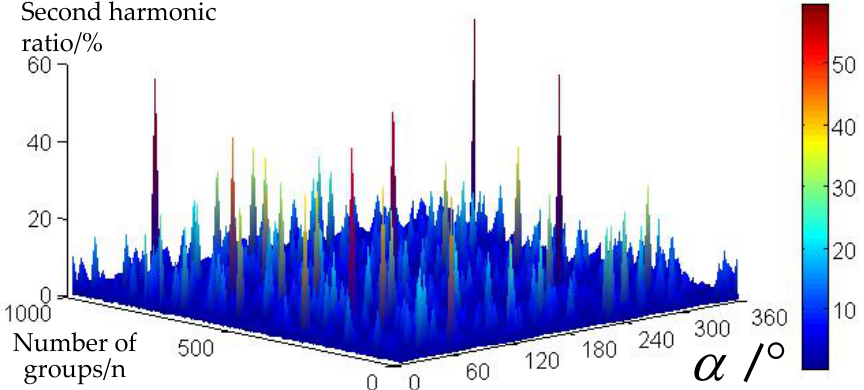
Figure 9. Relationship between second harmonic ratio and closing angle under random remanences.